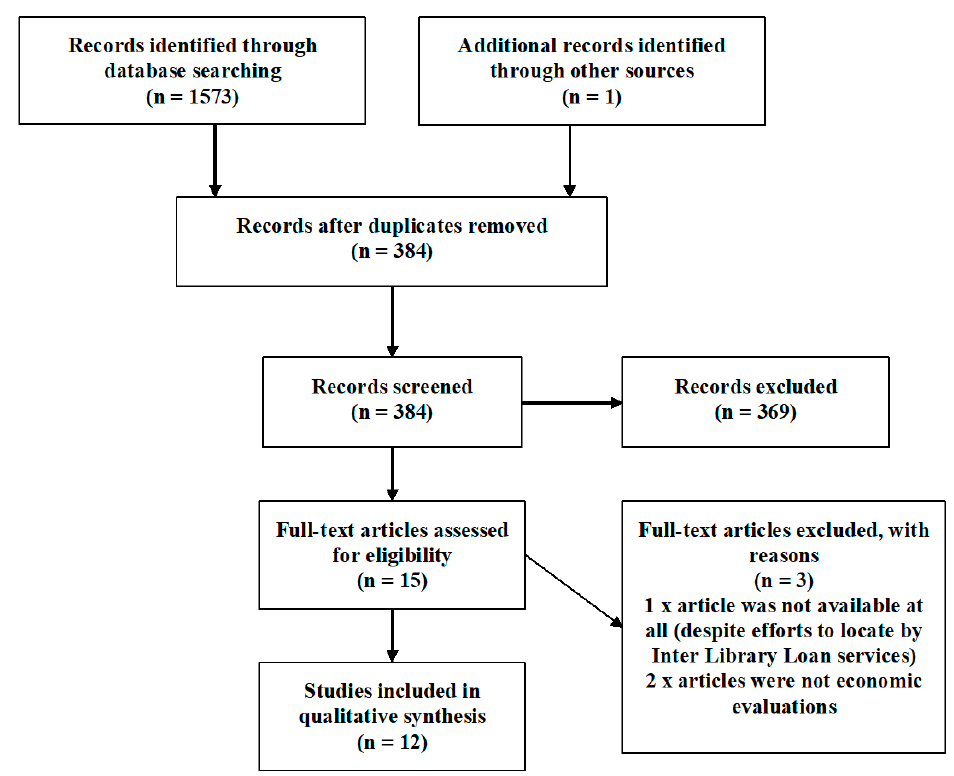
Figure 1. Preferred Reporting Items for Systemic Reviews and Meta-Analyses (PRISMA) 2009 [42] flow diagram for the valuing nature systematic review.